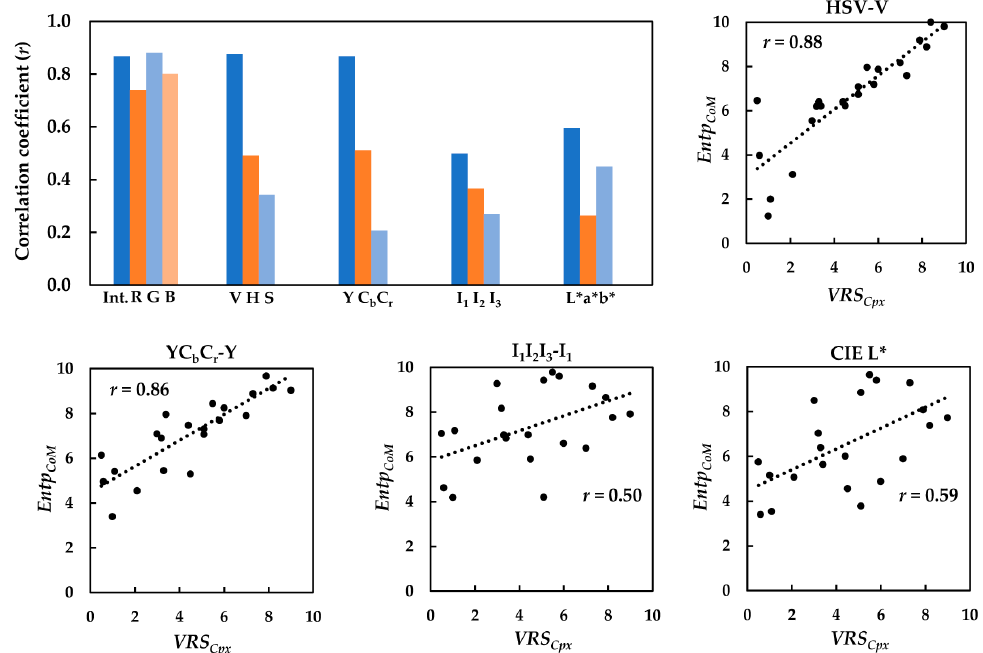
Figure 14. The correlation between the VRS Cpx of the textiles and Entp CoM computed for the lumi- nance and chrominance channels of the textile images in the sRGB, HSV, YC b C r , I 1 I 2 I 3 , and CIELAB color spaces with the CoM distance d = 100 pixels. Here, ‘Int.’ refers to the sRGB intensity image ( top left ). Scatter plots of Entp CoM versus the corresponding VRS Cpx for the luminance channel of the tex- tile images in the HSV, YC b C r , I 1 I 2 I 3 , and CIELAB color spaces.